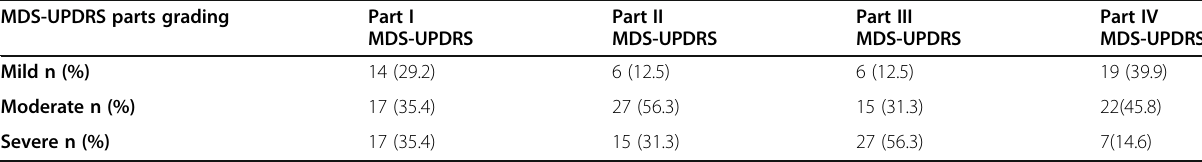
Table 1 Total score of different parts of Movement Disorder Society-Sponsored Revision of the Unified Parkinson ’ s Disease Rating Scale